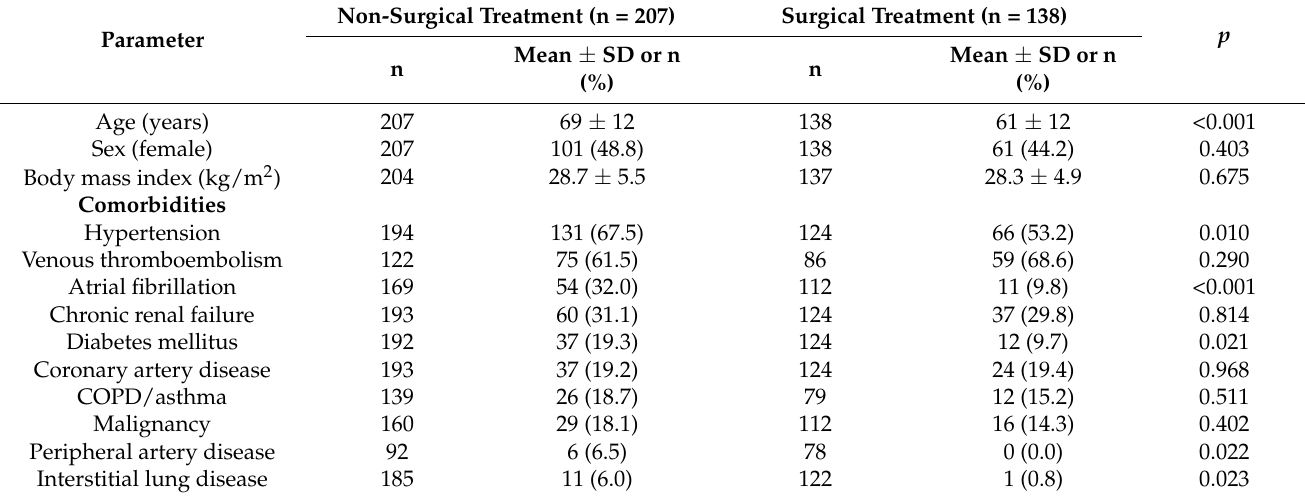
Table 1. Anthropometric Data and Comorbidities.